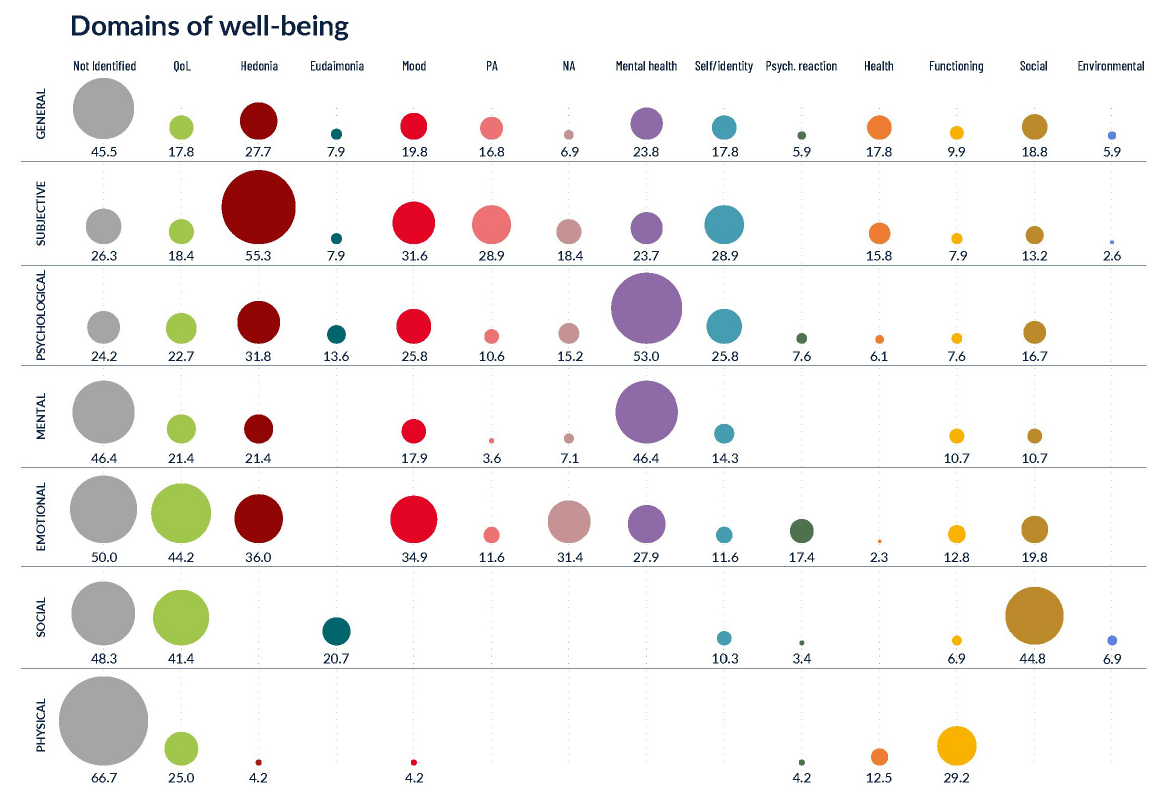
(language, art, literature, and other cultural symbols) . One article, respectively, referred to global well-being (conceptualized as life satisfaction and depression ) and optimal well-being (not clearly